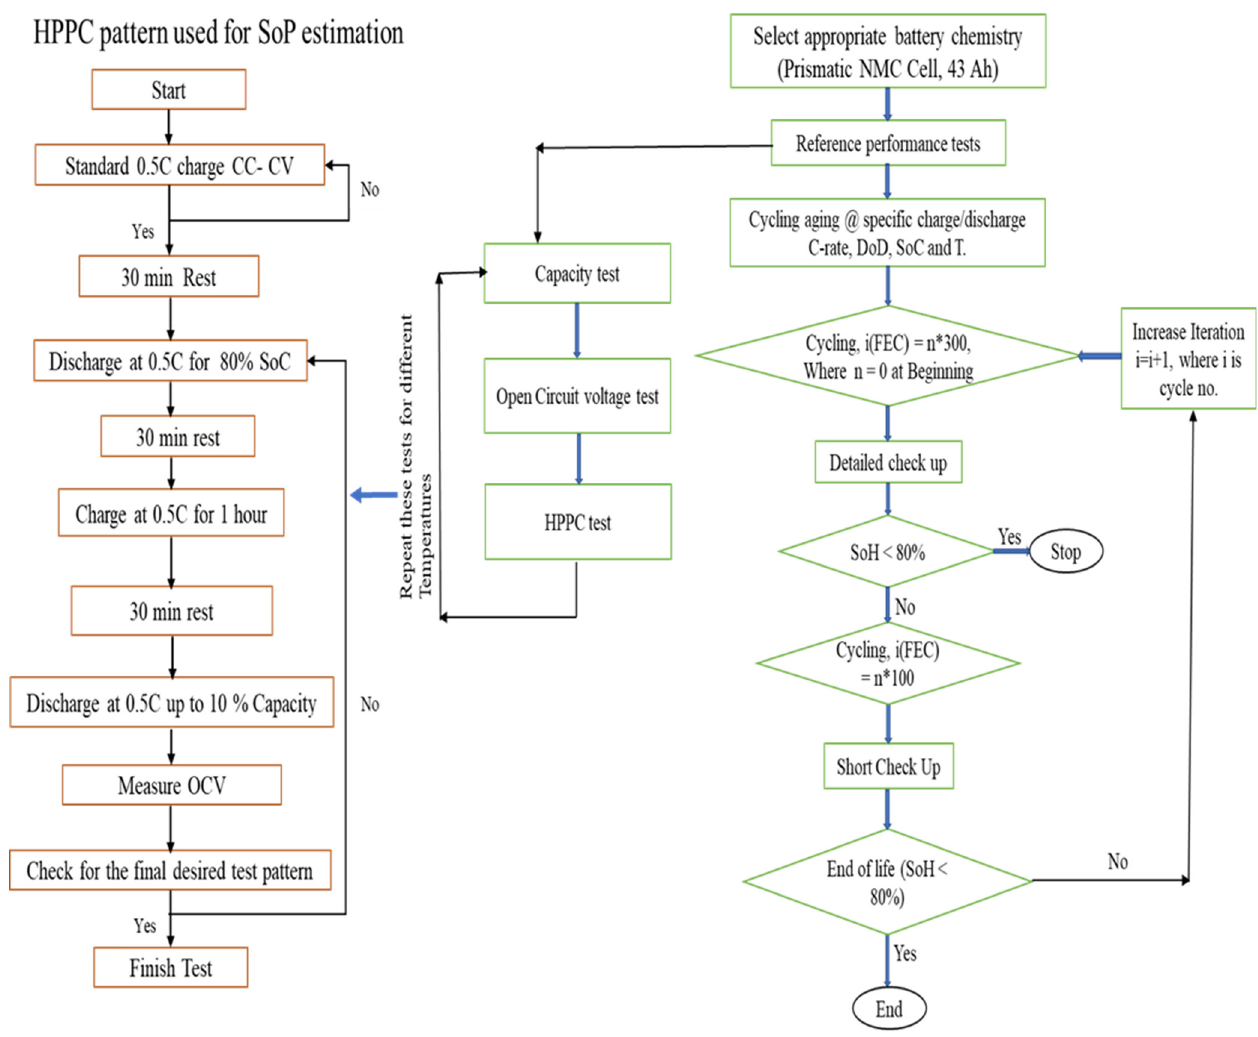
Figure 2. Flowchart of the overall characterization procedure.